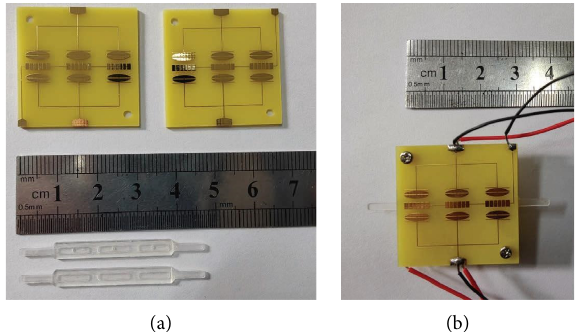
Figure 7: Te confguration of the phase shifter: (a) components and (b) whole.